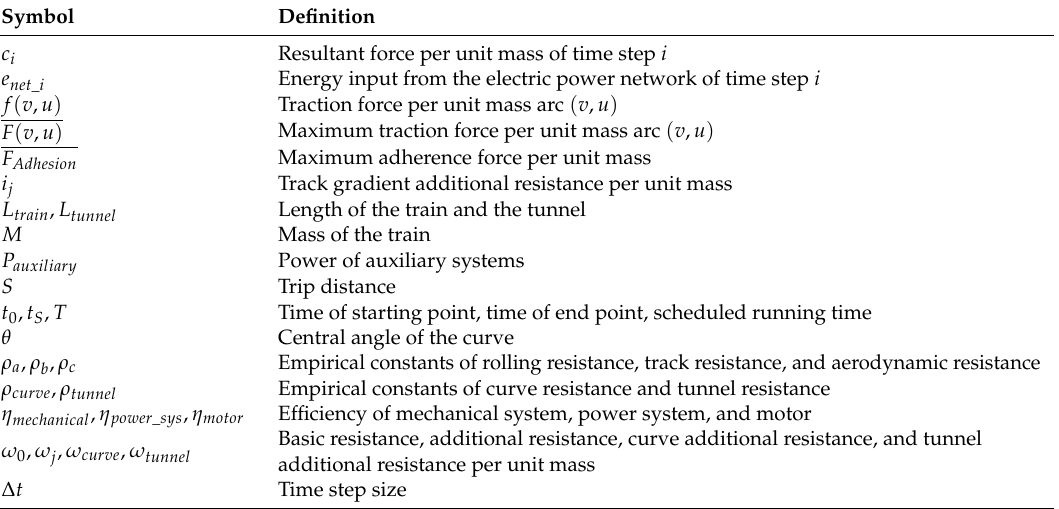
Table A1. Subscripts, parameters, and variables used in the mathematical